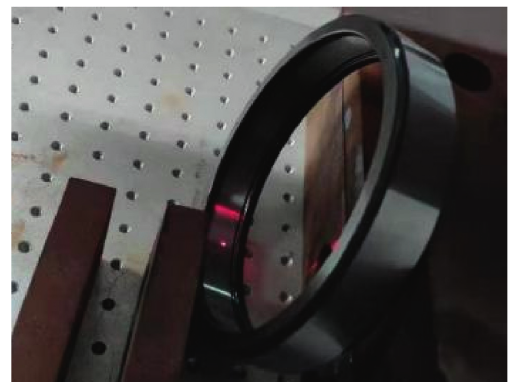
Figure 3: Prefabricated defect on the bearing outer